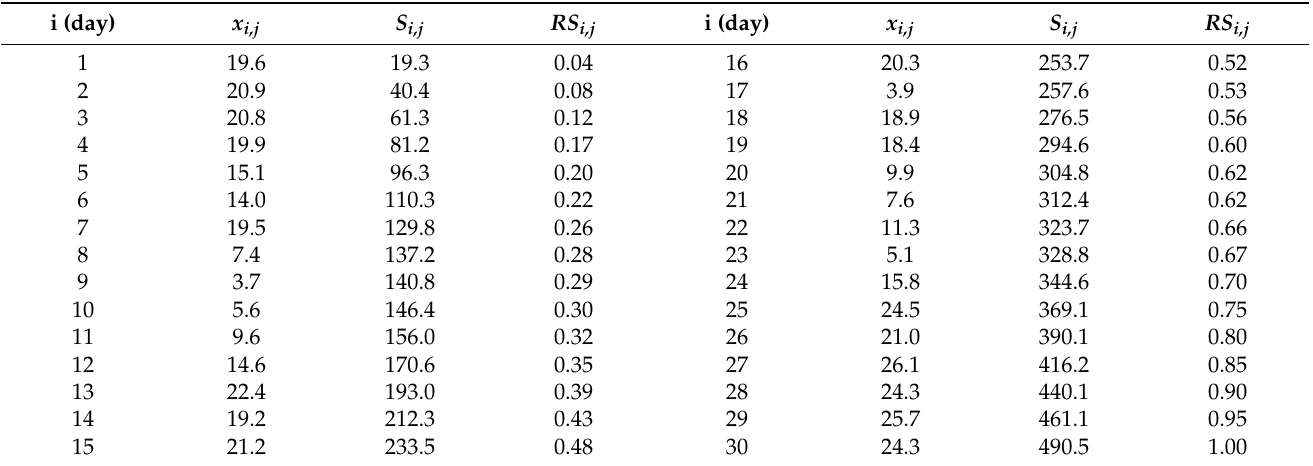
Table 1. An example of deriving the (8) and (10) parameters. Here, x i , j is the daily (i) global radiation in April 2001, i.e., on month 4 of the data matrix of Szeged.